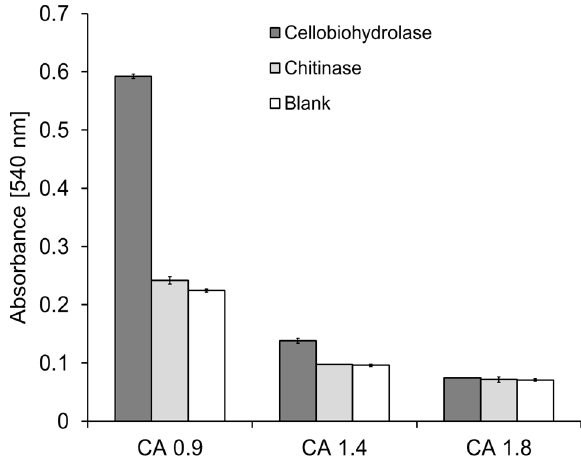
Figure 7. Backbone cleavage of cellulose acetates with chitinase and cellobiohydrolase I after 145 h.